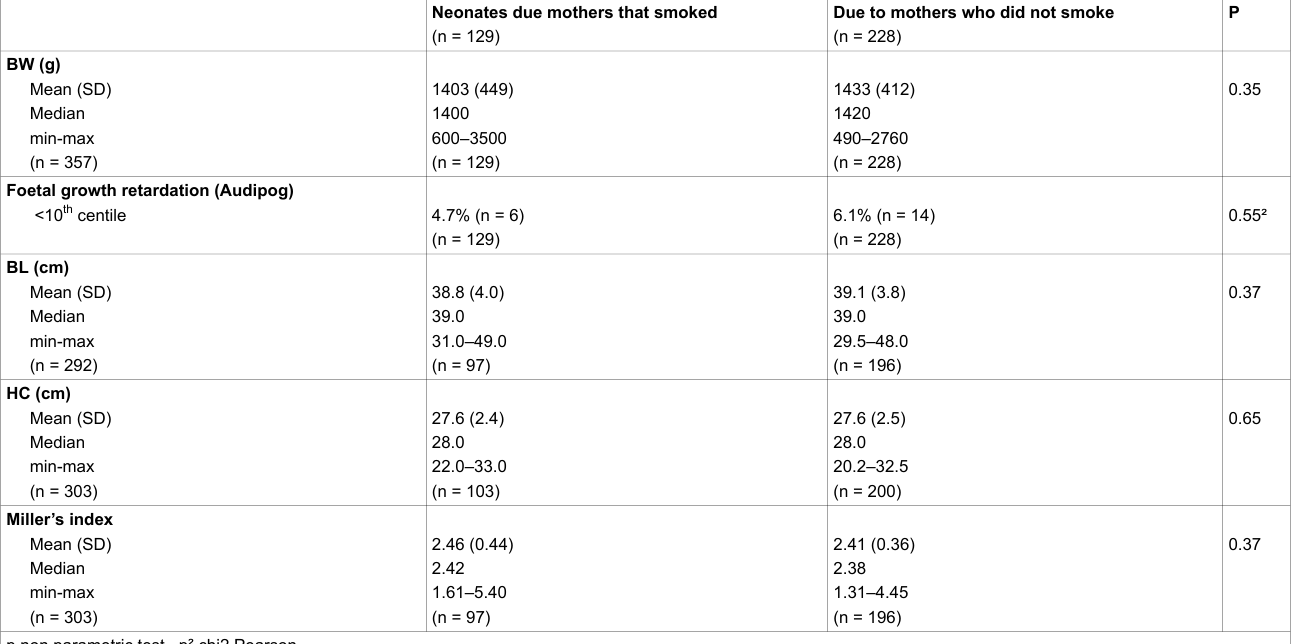
Table 2a: Comparison of fœtal growth parameters in preterm infants (GA 24–32 weeks) born to smokers versus those born to non